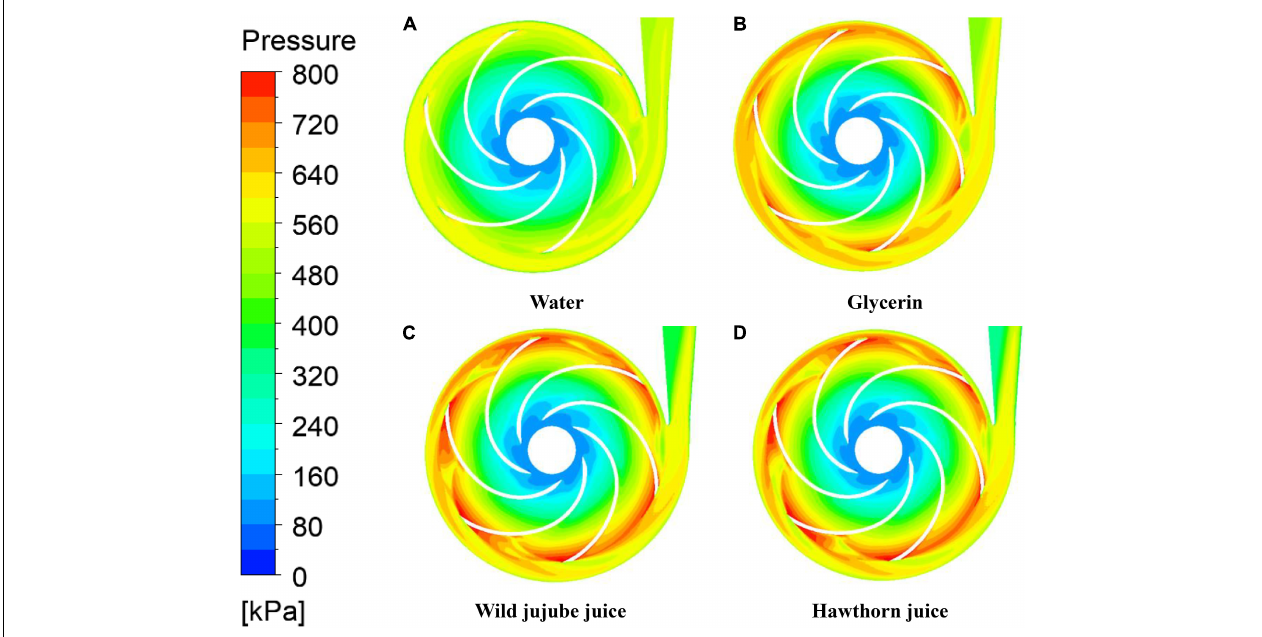
FIGURE 8 | Total pressure of the centrifugal pump with different viscosity. (A) Water, (B) Glycerin, (C) Wild jujube juice and (D) Hawthorn juice.